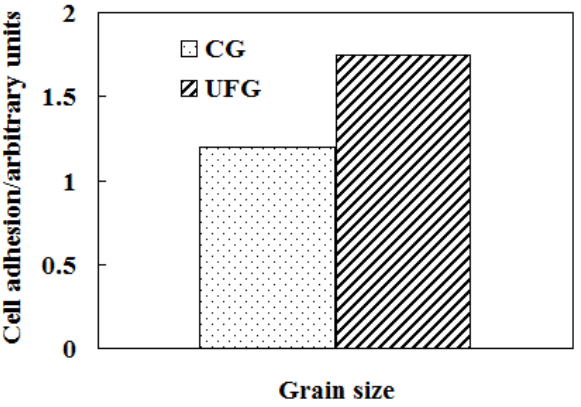
Figure 12. Enhanced osteoblast adhesion on ultrafine-grained (UFG) CP Ti compared to CG CP Ti [147]. Reprinted with permission from [147]. Copyright 2004